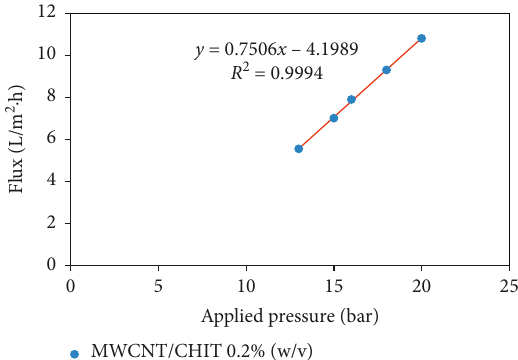
Figure 6: Water permeability of the MWCNT/CHIT evaporative cast membrane.